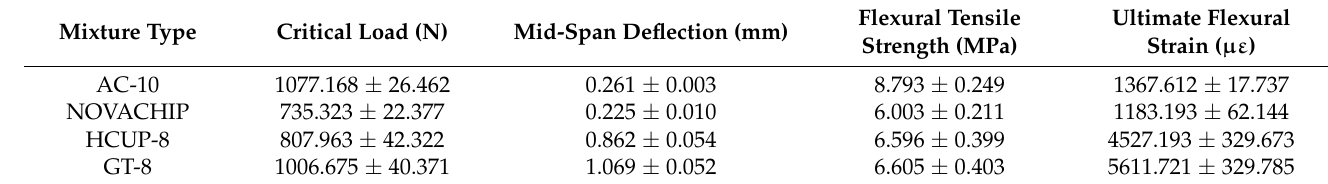
Figure 6. Load-displacement curve of low temperature bending test.